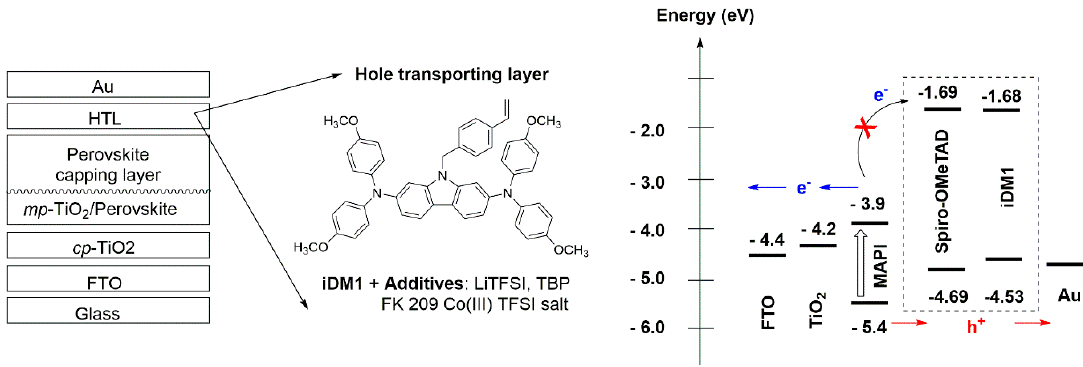
Figure 2. Perovskite device structure and energy alignment of different device component.